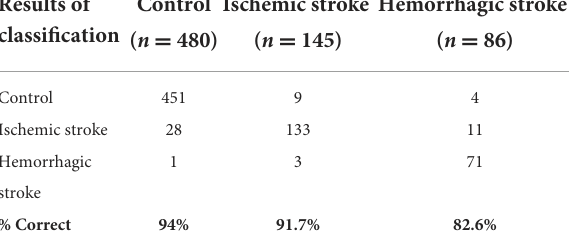
TABLE 5 Ten-fold cross-validation of all three